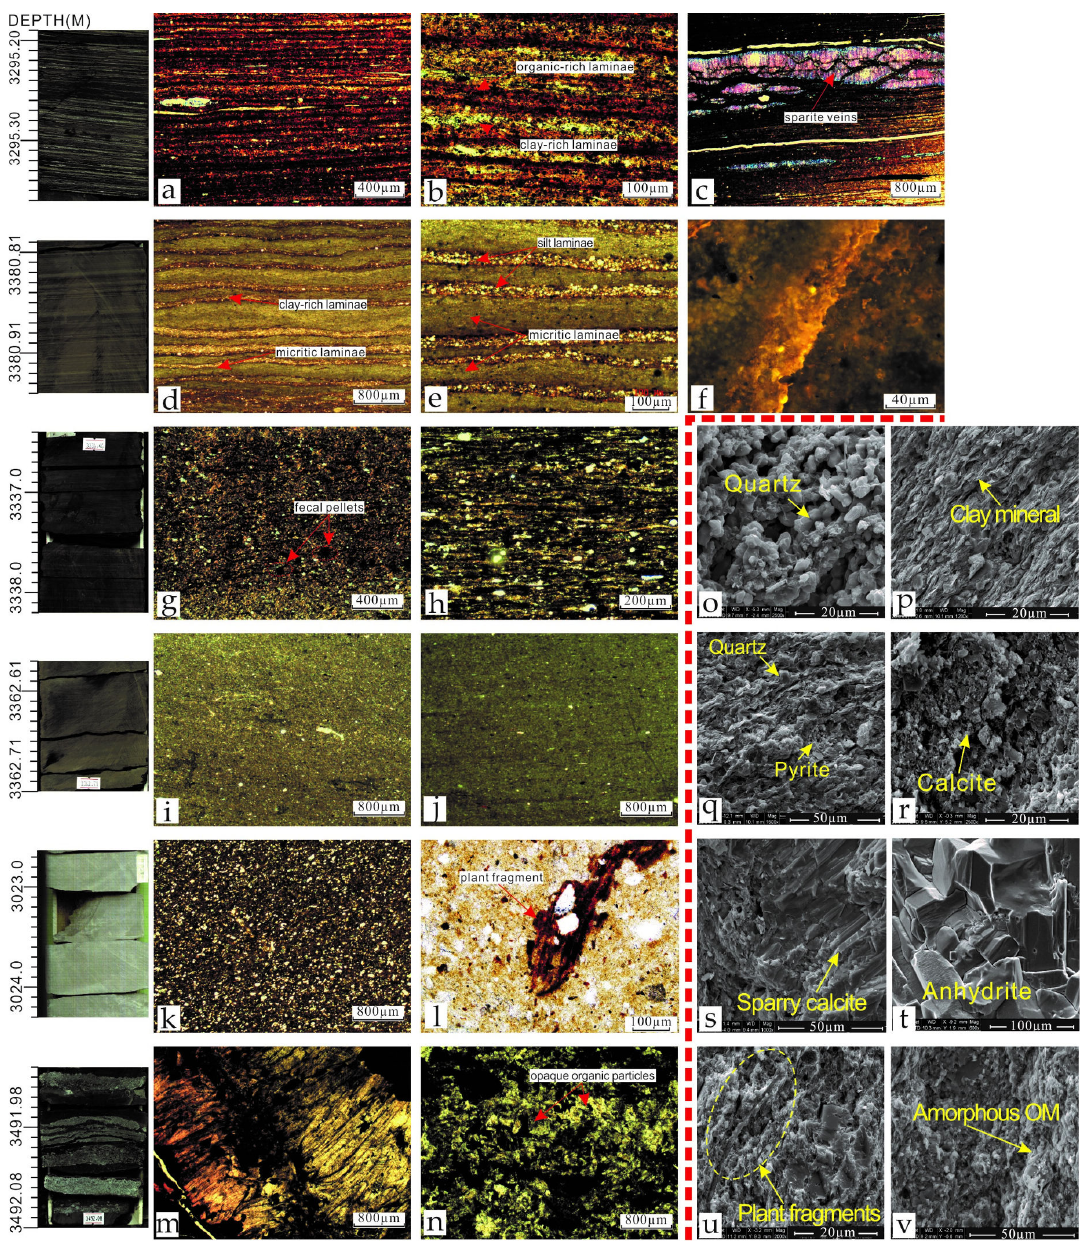
Figure 3. Photomicrographs and SEM images of lithology characteristics in the Dongying Sag. ( a , b ) Finely laminated shale, consisting of organic-rich laminae (dark) and clay-rich laminae (light). ( c ) Sparite vein preserved in finely laminated shale. ( d ) Widely laminated shale, consisting of micritic laminae and clay-rich laminae. ( e ) Couplets of micritic laminae and silty laminae in widely laminated shale. ( f ) Micritic carbonate laminae under fluorescent light. ( g , h ) Discontinuous laminated shale, fossils of fecal pellets can be seen in rocks ( i , j ) Homogeneous massive mudstone. ( k ) Silt-size particles randomly speared in silt-rich mudstone. ( l ) Fragments of terrestrial plant preserved in silt-rich mudstone. ( m , n ) Anhydrite layers in anhydrite-rich mudstone. ( o ) SEM image of quartz anhydrite-rich mudstone. ( p ) SEM image of parallel orientation of clay flakes. ( q ) SEM image of pyrite and quartz particles preserved in clay-rich laminae. ( r ) SEM image of micritic calcite grain smaller than 4 µ m. ( s ) SEM image of sparry calcite preserved in sparite vein. ( t ) SEM image of anhydrite preserved in anhydrite layer. ( u ) SEM image of plant debris preserved in silt-rich mudstone. ( v ) SEM of amorphous OM preserved in organic-rich